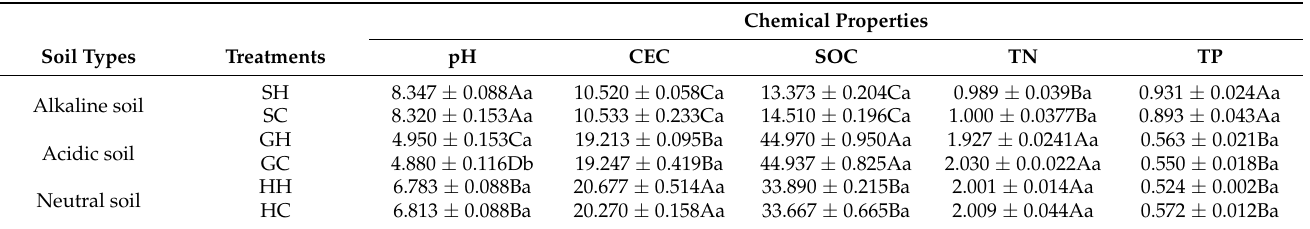
Table 1. Soil properties at each soil with different treatments. Abbreviations: TN, total nitrogen; TP, total